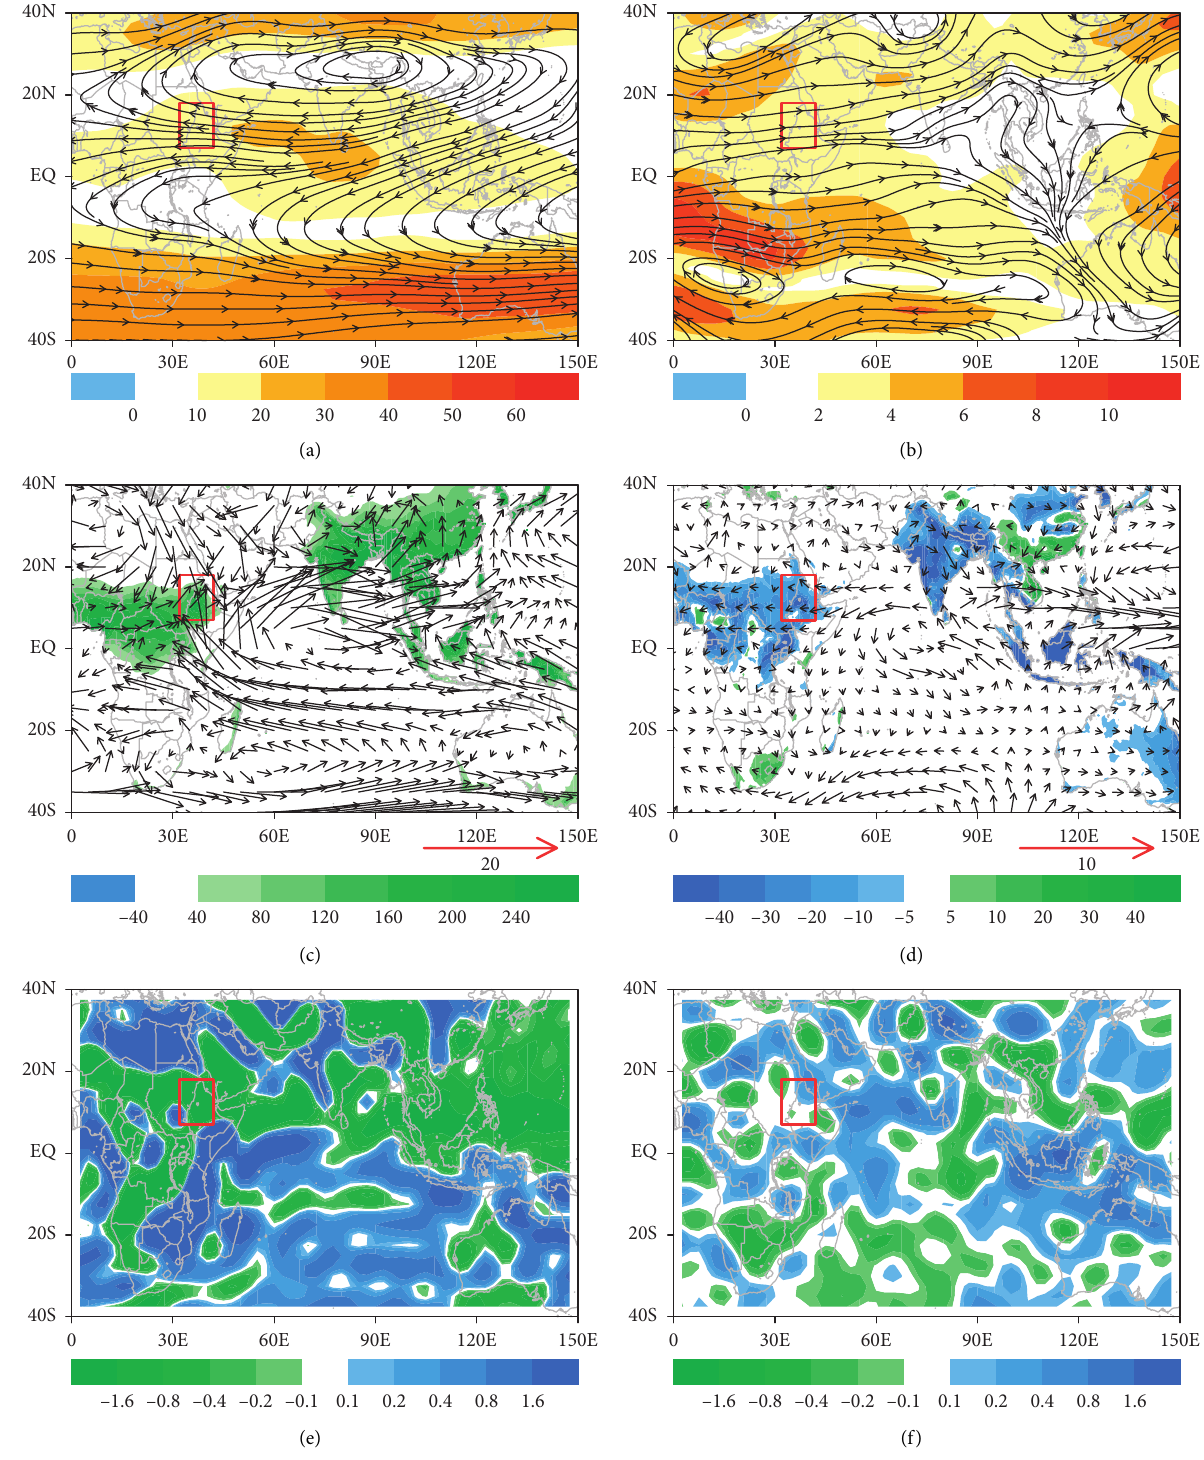
Figure 9: Climatological (a) 200-hPa wind (streamline), (c) 850-hPa wind (vector in m/s) and rainfall (shaded in mm month − 1 ), and (e) 850- hPa divergence (shaded in 10e6 s − 1 ) in JJAS. The difference of (b) 200-hPa wind (streamline), (d) 850-hPa wind (vector in m s − 1 ), rainfall (shaded in mm/month), and (f) 850-hPa divergence (shaded in 10e6 s − 1 ) in JJAS between El Nin ̃ o and La Nin ̃ a years. The magnitudes of wind are shaded in (a) and (b). The red box marked in each panel represents the JJAS